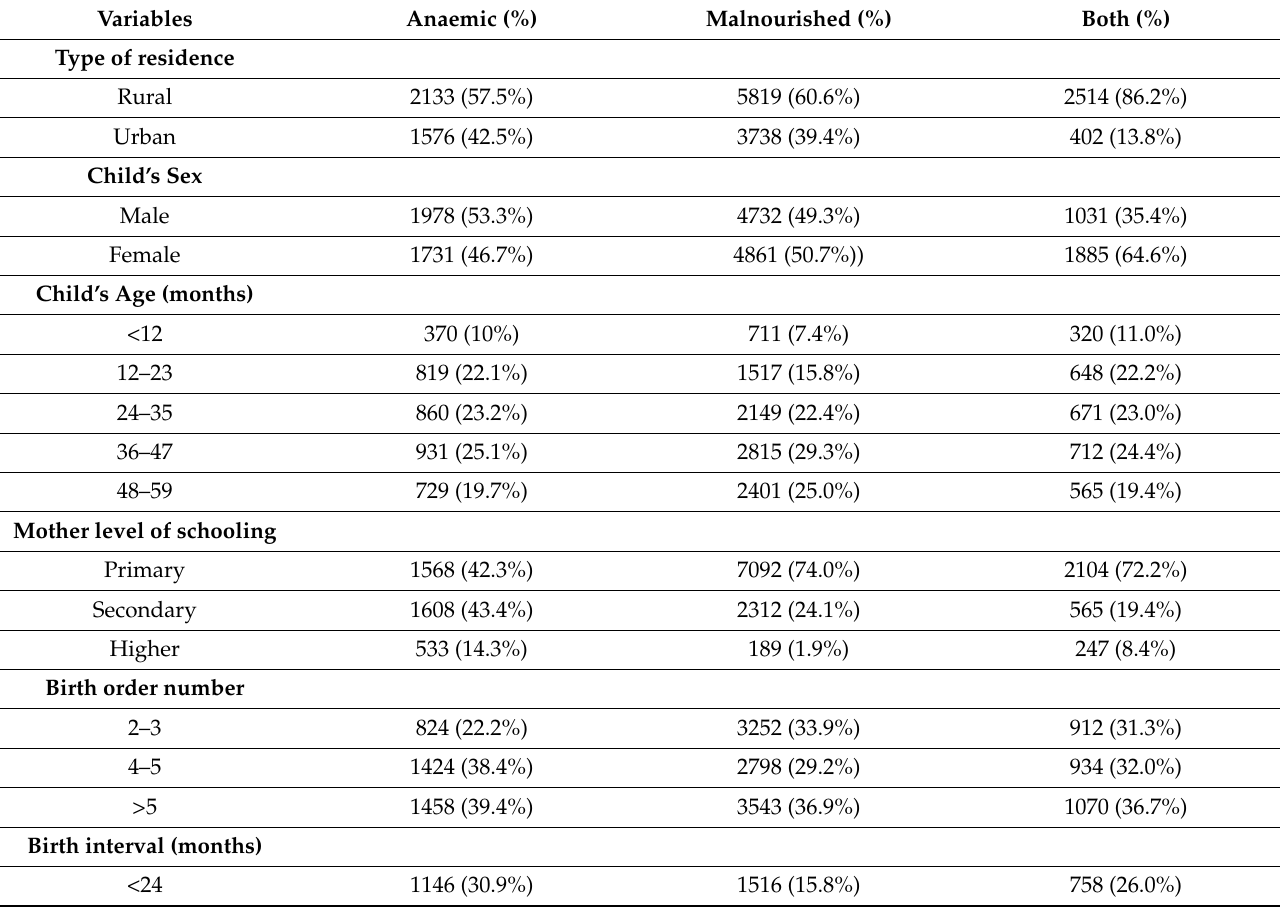
Table 2. The distribution of children’s outcomes by explanatory